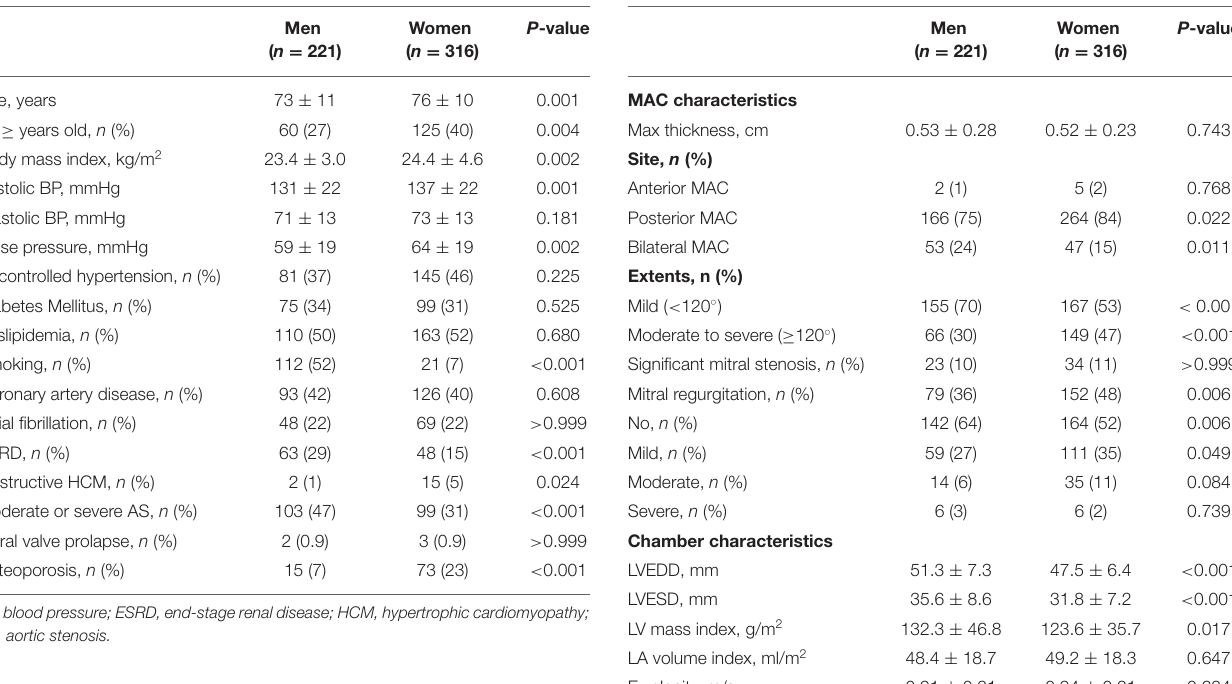
TABLE 1 | Baseline characteristics. TABLE 2 | Echocardiographic